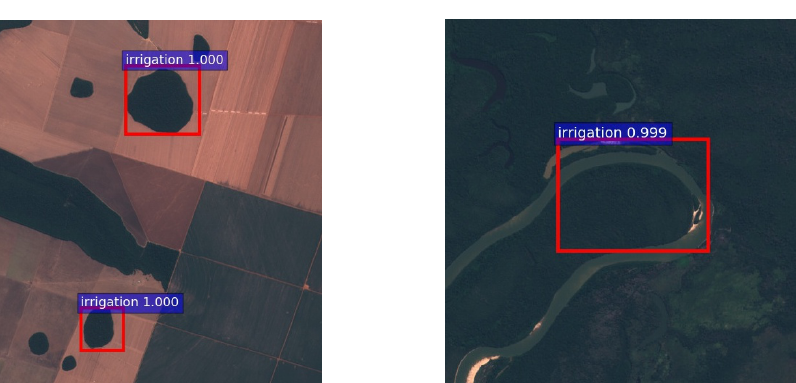
Figure 9. Examples of false detections of